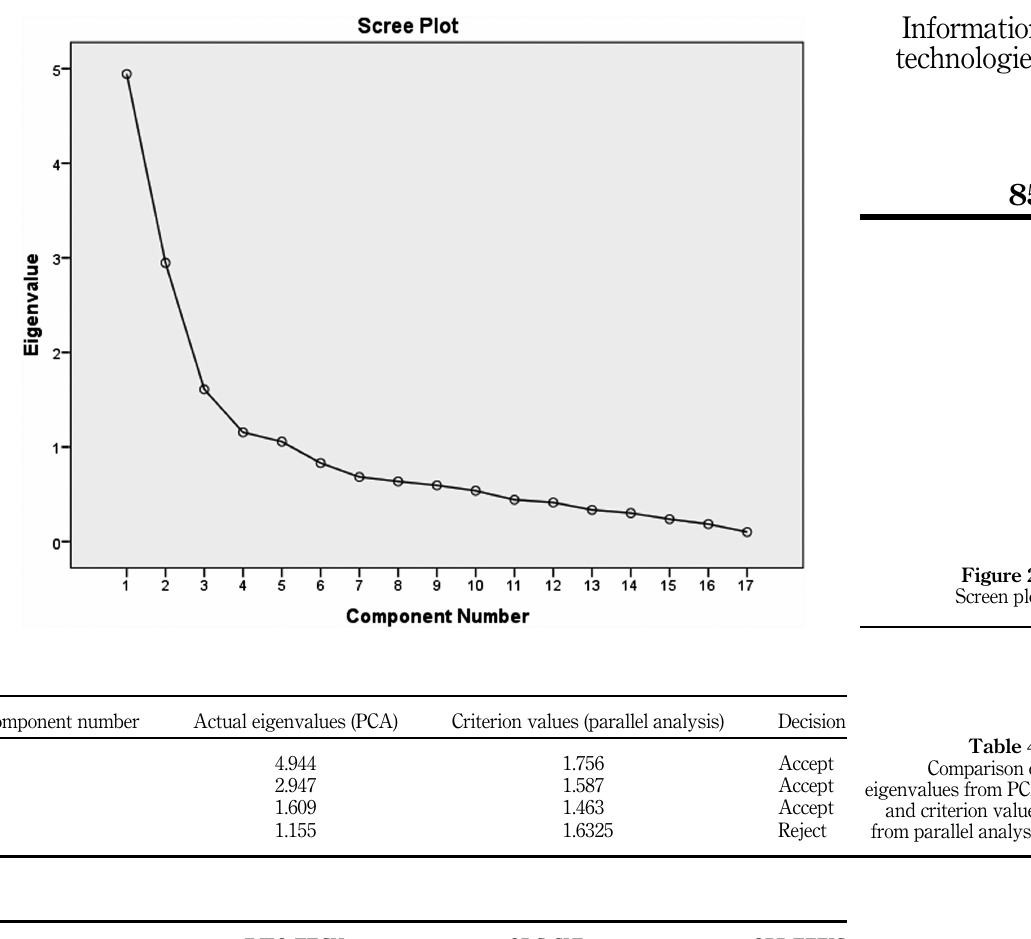
Figure 2. Screen plot